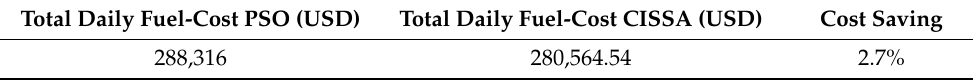
Table 19. Emissions comparison between CISSA and